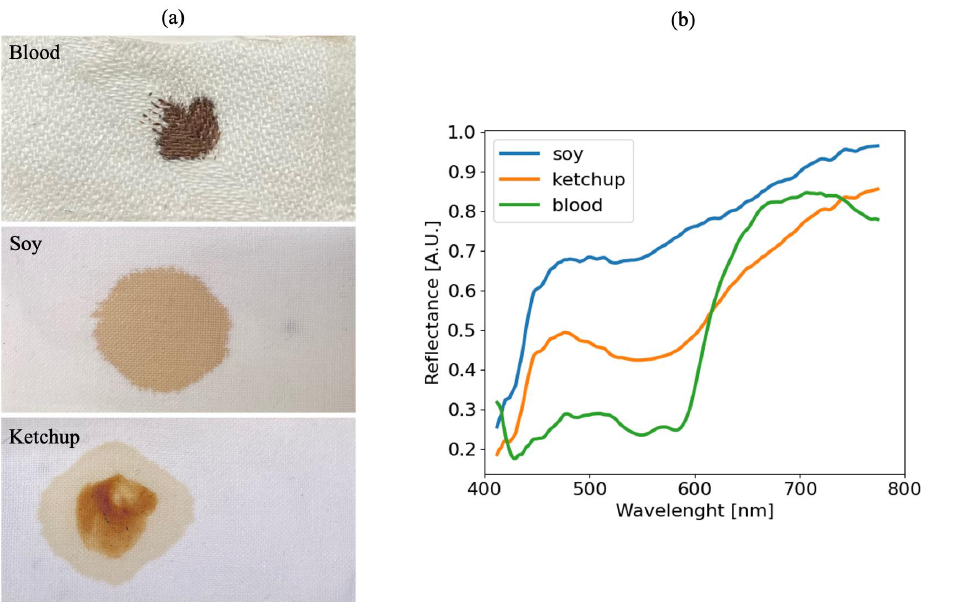
Figure 4. Blood, soy, and ketchup stain images ( a ), reflectance spectra comparison ( b ), [A.U.] means non-dimensional